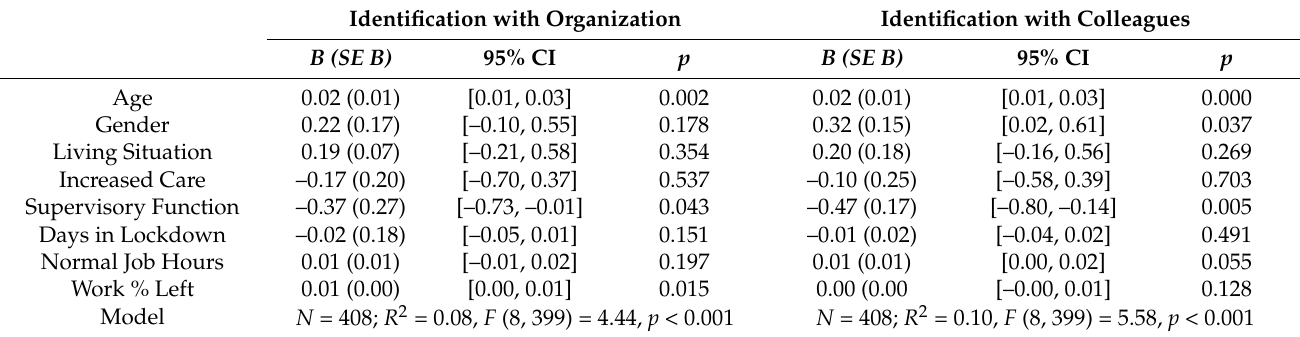
Table 5. Multiple regression analysis of work percentage left on identification.